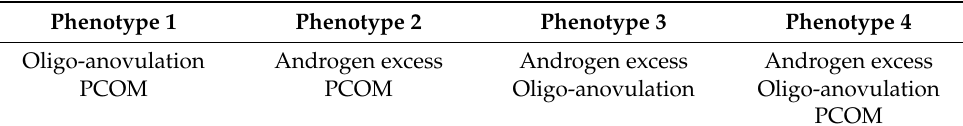
Table 1. The four phenotypes of PCOS according to the 2003 Rotterdam Criteria